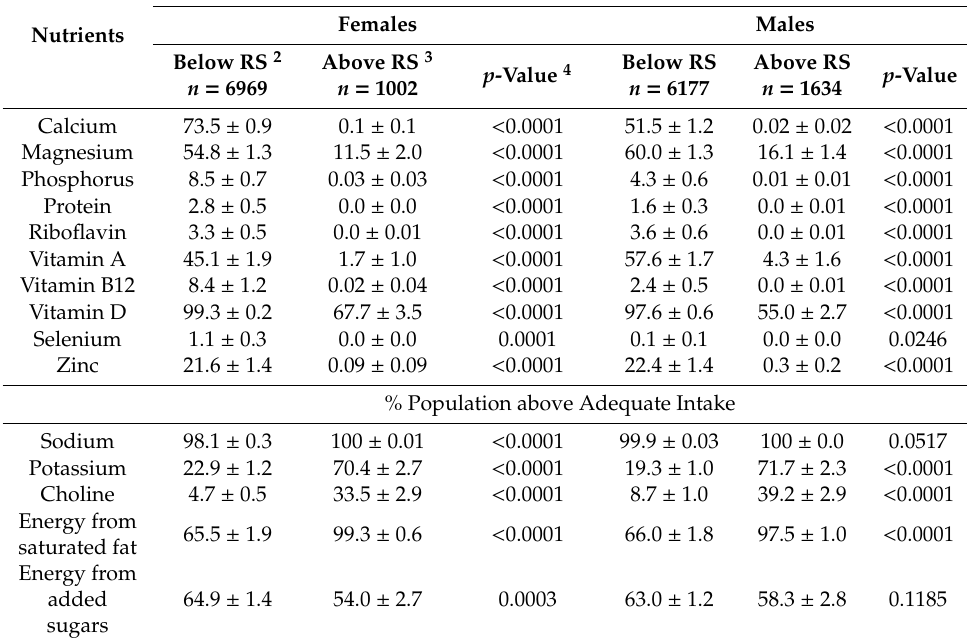
Table 6. Percent U.S. population (by sex) below the Estimated Average Requirement or Above Adequate Intake among those consuming above recommended daily servings of dairy (Above RS) and below recommended daily servings of dairy (Below RS), ages 2 + , in the National Health and Nutrition Examination Survey 2013–2016 1